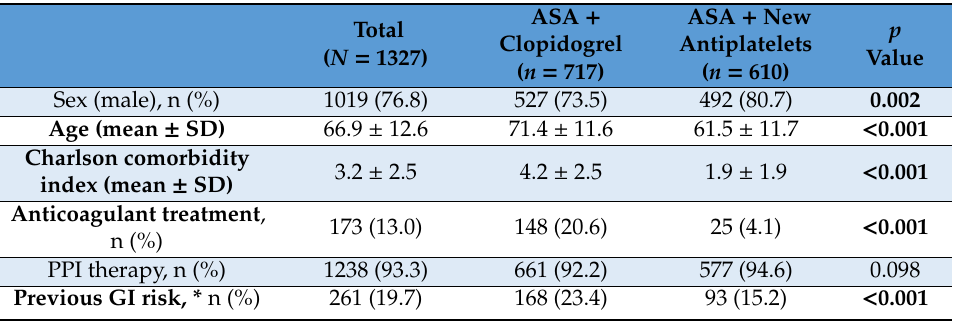
Table 1. Baseline